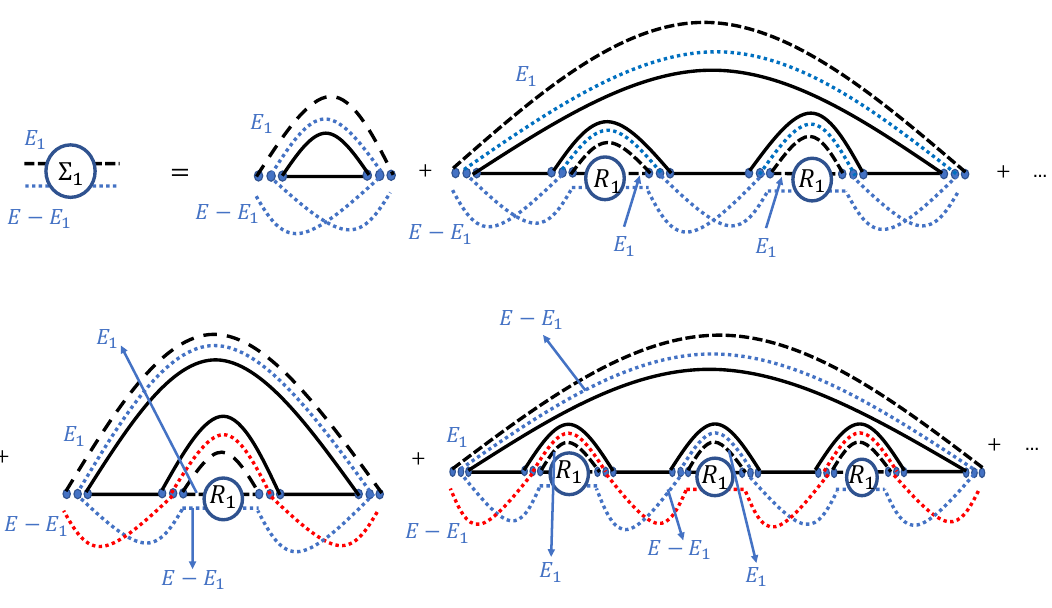
Figure 28 . Schwinger-Dyson equation for different contributions to Σ 1 ( E 1 )